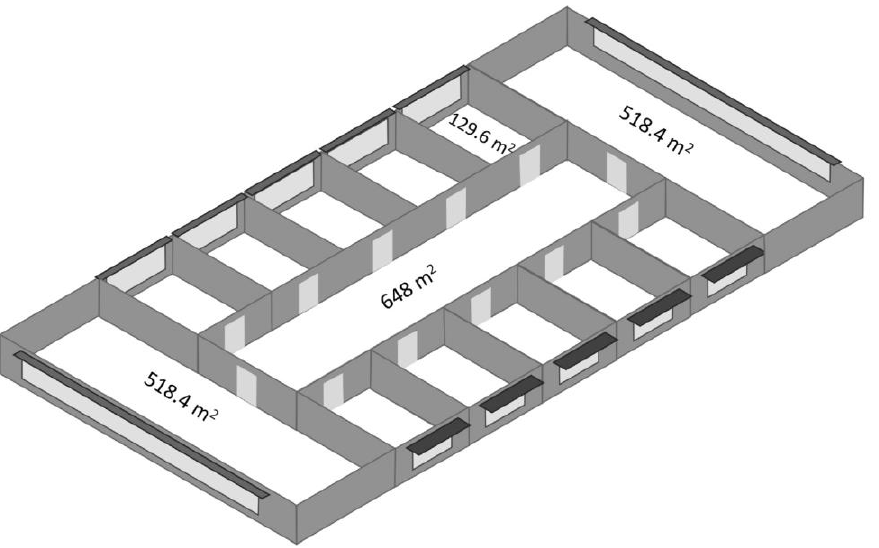
Figure 5. Building model of BEO problem for detailed office building [34].